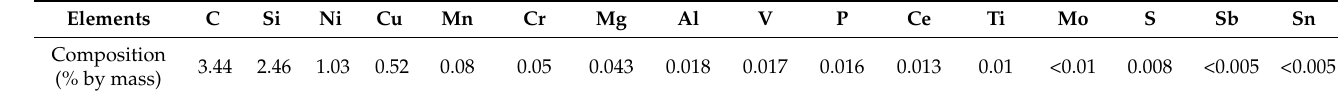
Figure 22. Morphological structure of the ductile iron after heat treatment at 1520 ◦ F and austemper- Table 4. Chemical composition of austempered ductile cast